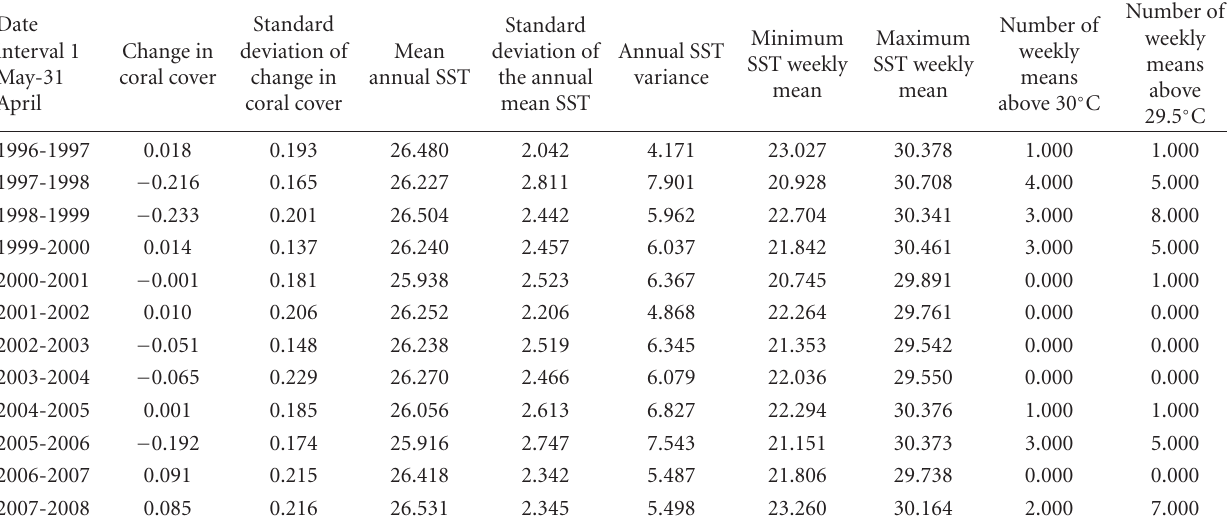
Table 1: Statistical summary of the weekly SST mean time series and comparison with annual mean coral cover